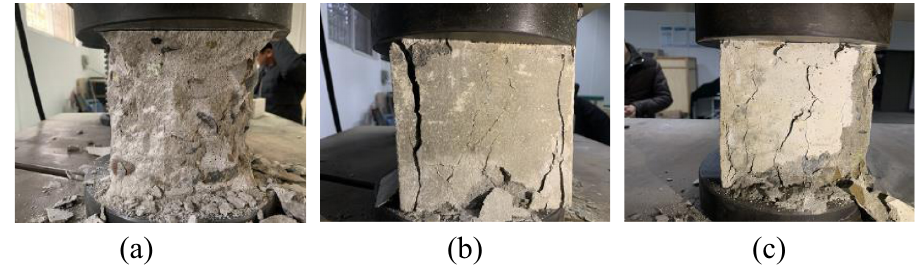
Figure 11: Failure mode of cube compressive strength: ( a ) NC, ( b ) PSFC, and ( c ) RSFC.